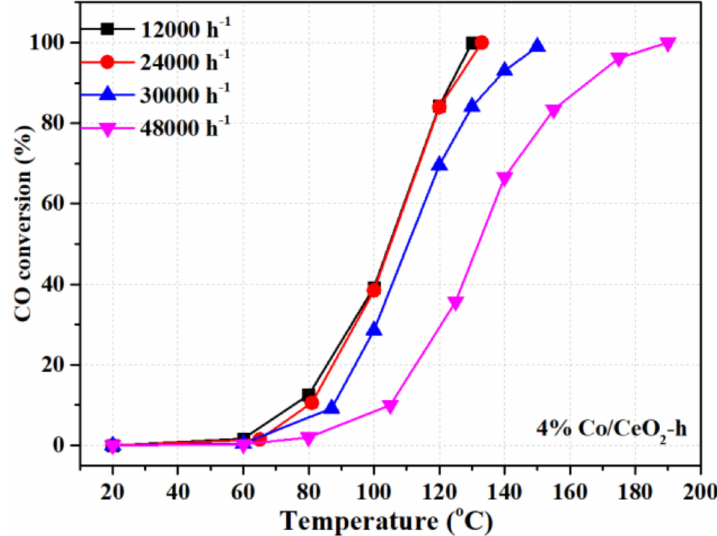
Figure 3. CO conversions of 4% Co / CeO 2 -h under di ff erent gas hourly space